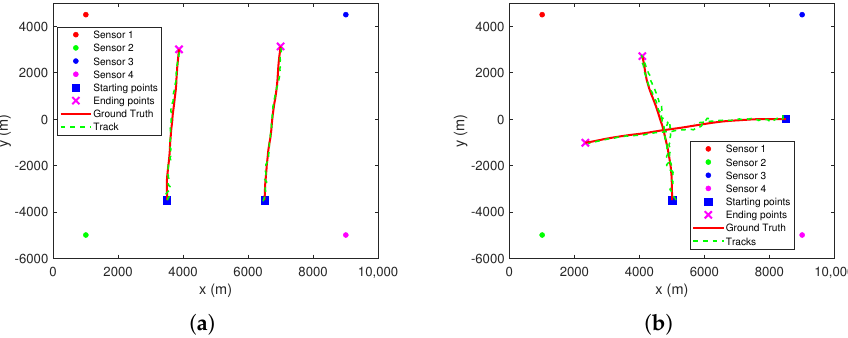
Figure 17. Tracking results. ( a ) Scenarios 4. ( b ) Scenarios